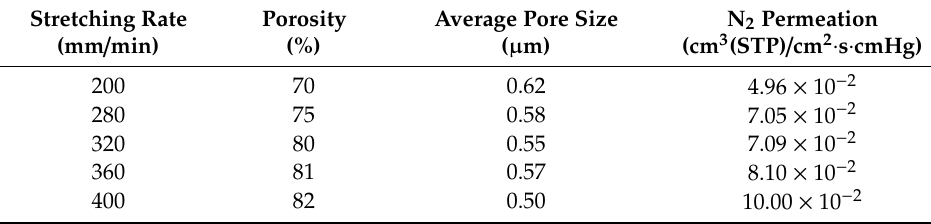
Table 5. Properties of microporous hollow fibers produced using di ff erent stretching rates